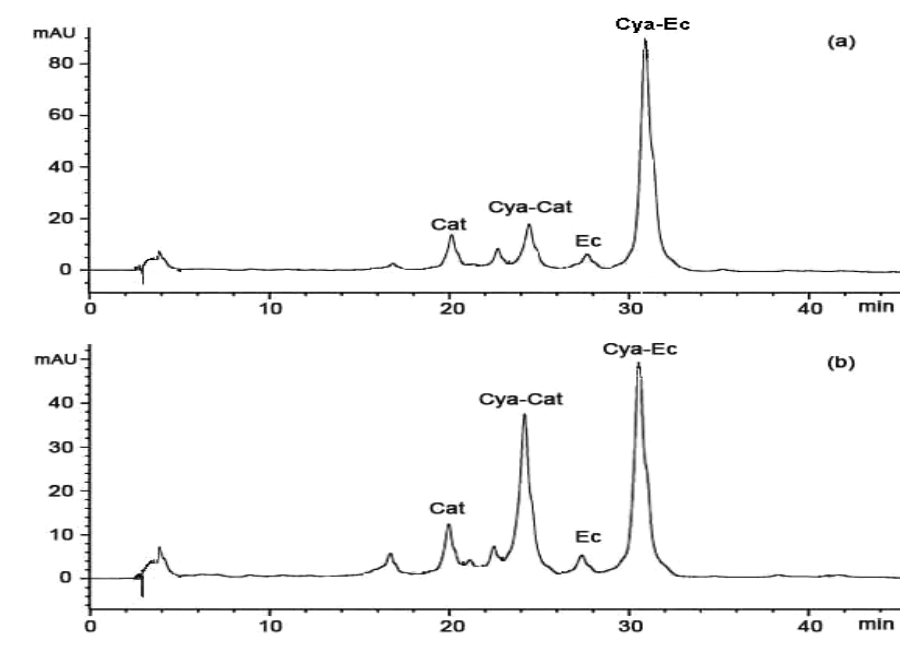
Figure 2. Reversed phase HPLC chromatograms of the condensed tannins from: (a) stem bark and (b) fine root degraded in the presence of cysteamine; Cat, (+)-catechin; EC, (-)- epicatechin; Cya-Cat, 4 β -(2-aminoethylthio)catechin; Cya-EC, 4 β